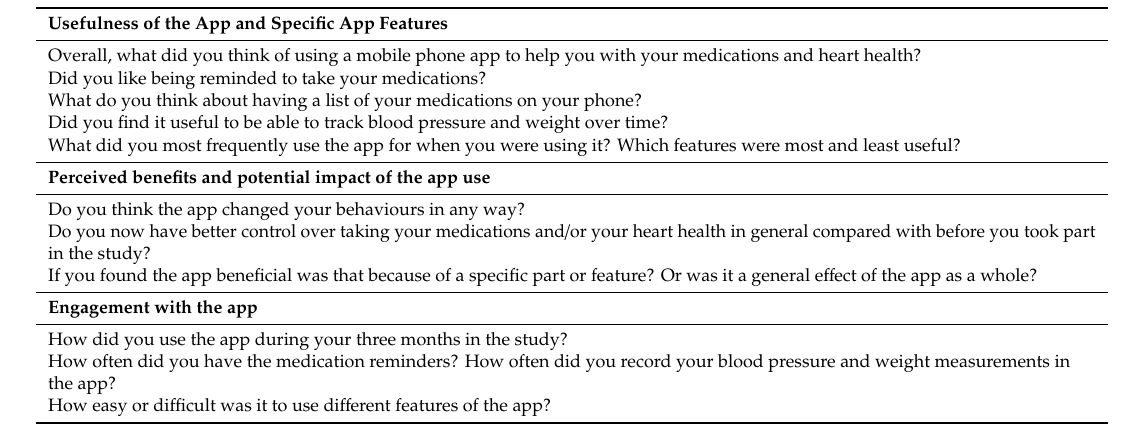
Table 2. Examples of questions to prompt focus group